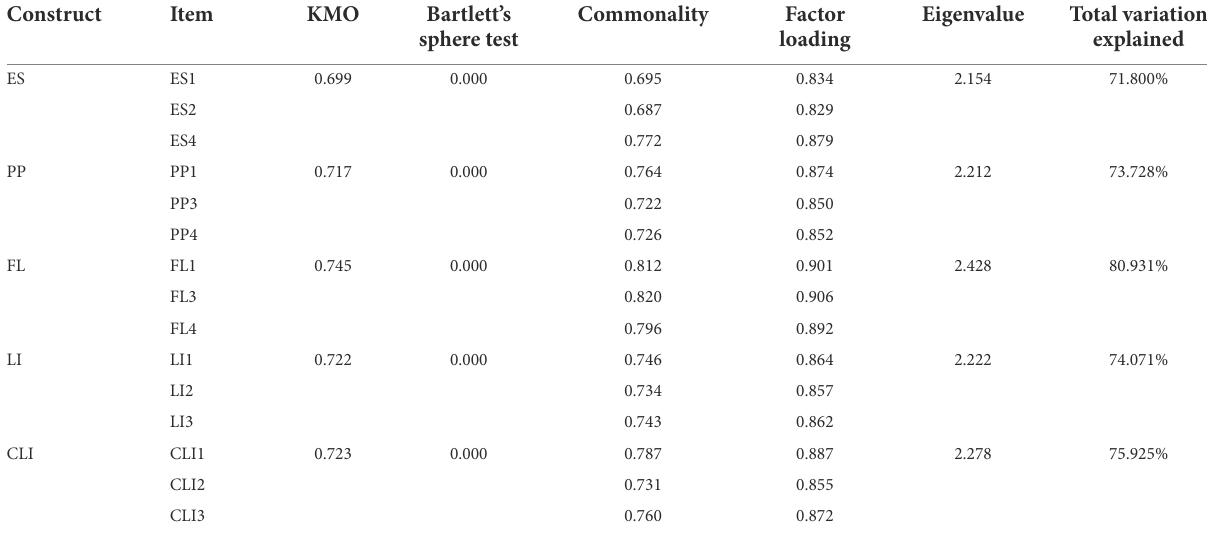
TABLE 3 Results of reliability analysis.